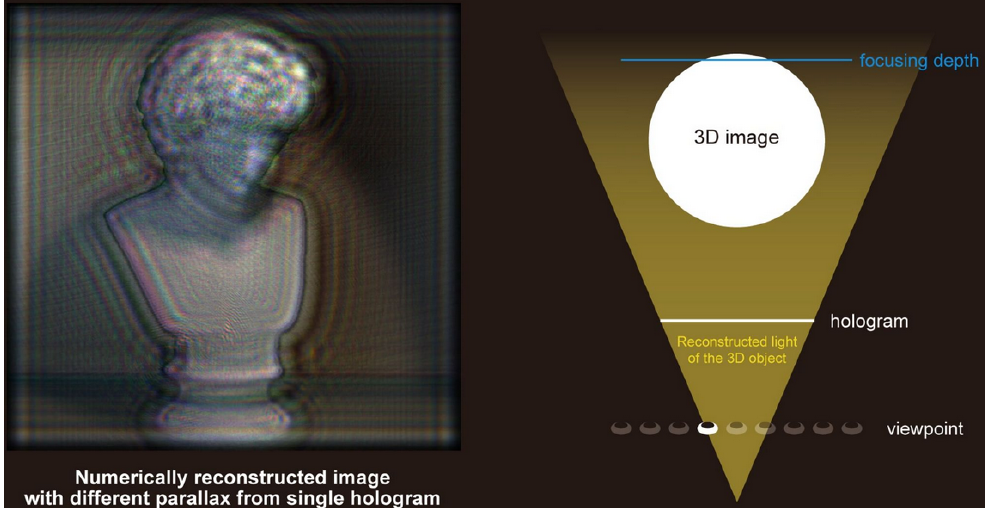
Figure 4. Screenshot of Video of “Antinous.” Three videos are provided in the Supplementary Materials. Figure 5 shows the calculation times of the proposed method and the conventional method as the function of the number of motion parallax. We used a central processing unit (CPU) and graphics processing unit (GPU) of Intel Core i7-4790 (3.60 GHz)